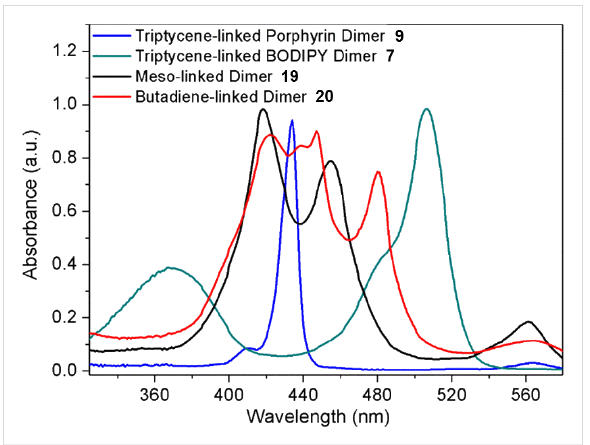
Figure 9: UV–vis spectra of various porphyrin/BODIPY dimers with dif- ferent linker groups in CHCl 3